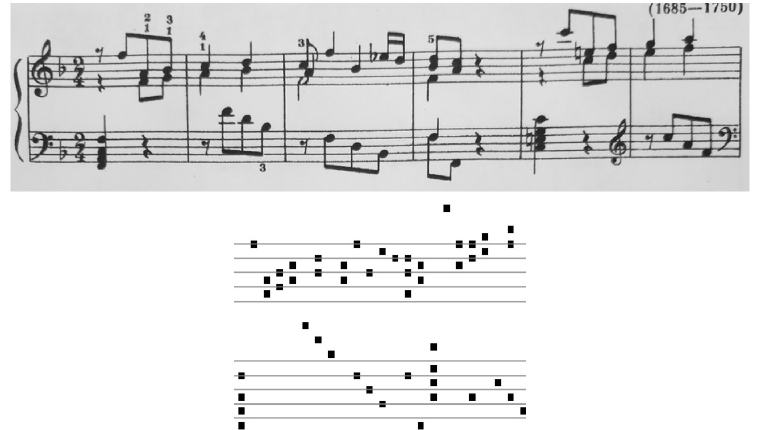
Figure 2. A short excerpt of sheet music and its corresponding bootleg score. Filled noteheads in the sheet music are identified and encoded as a sequence of binary columns in the bootleg score representation. The staff lines in the bootleg score are shown as a visual aid, but are not present in the actual